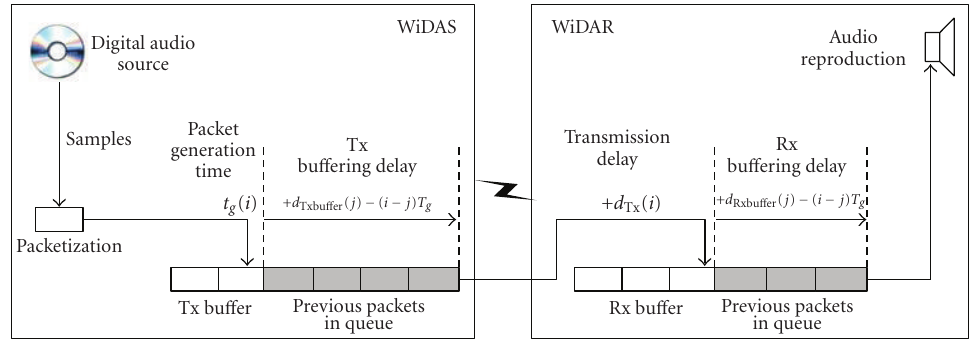
Figure 3: Representation of delay generation in packet-oriented WLAN audio